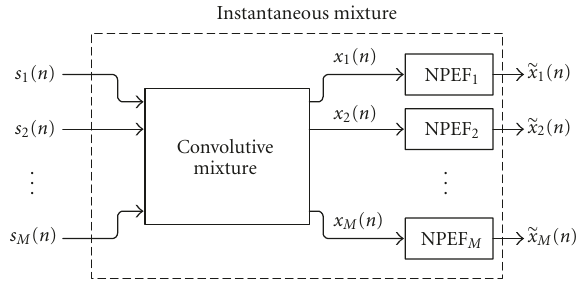
Figure 2: Converting a convolutive mixture problem to an instan- taneous